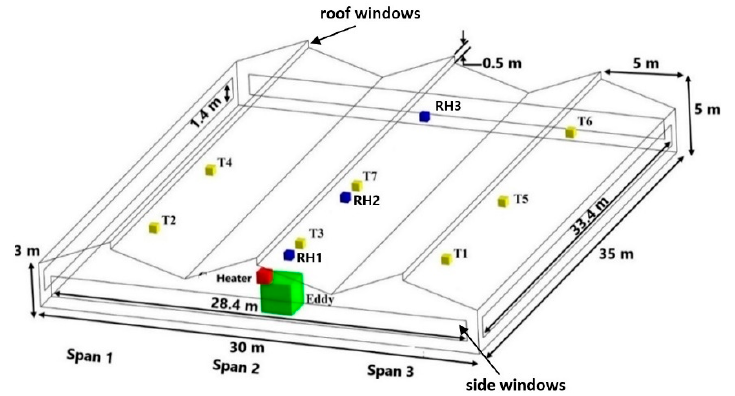
Figure 1. Dimensions and distribution of the heater ( ) and the temperature ( ), humidity ( ), and eddy covariance system ( ) sensors in the three spans of the experimental greenhouse.